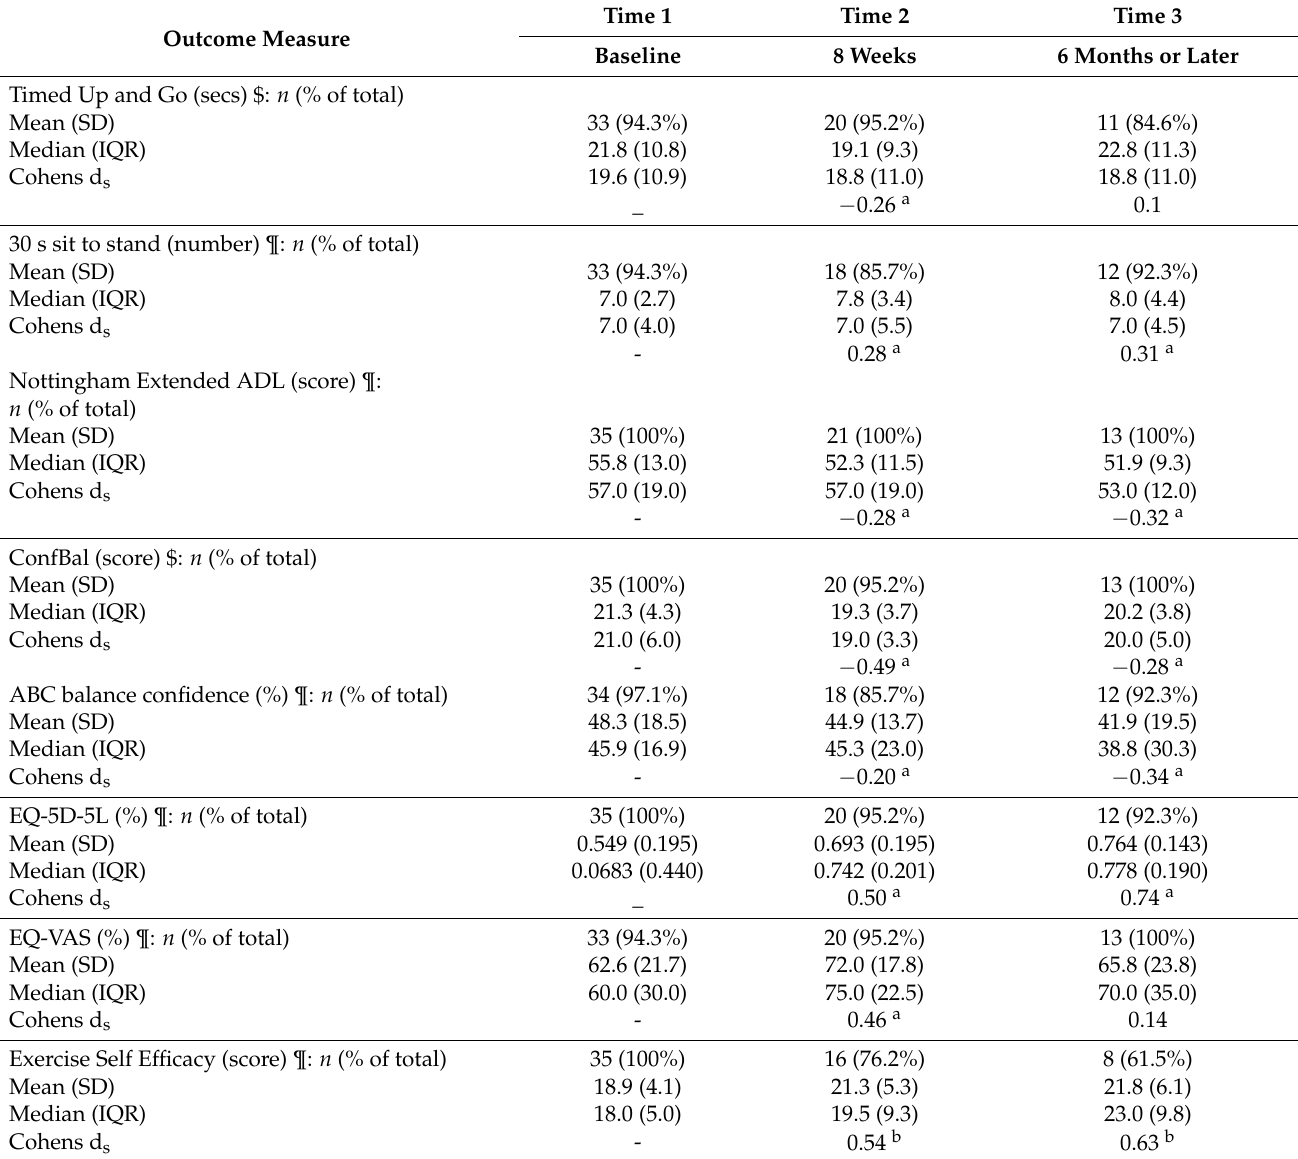
Table 2. Descriptive statistics and data loss for secondary outcome measures at Time 1, Time 2 and Time